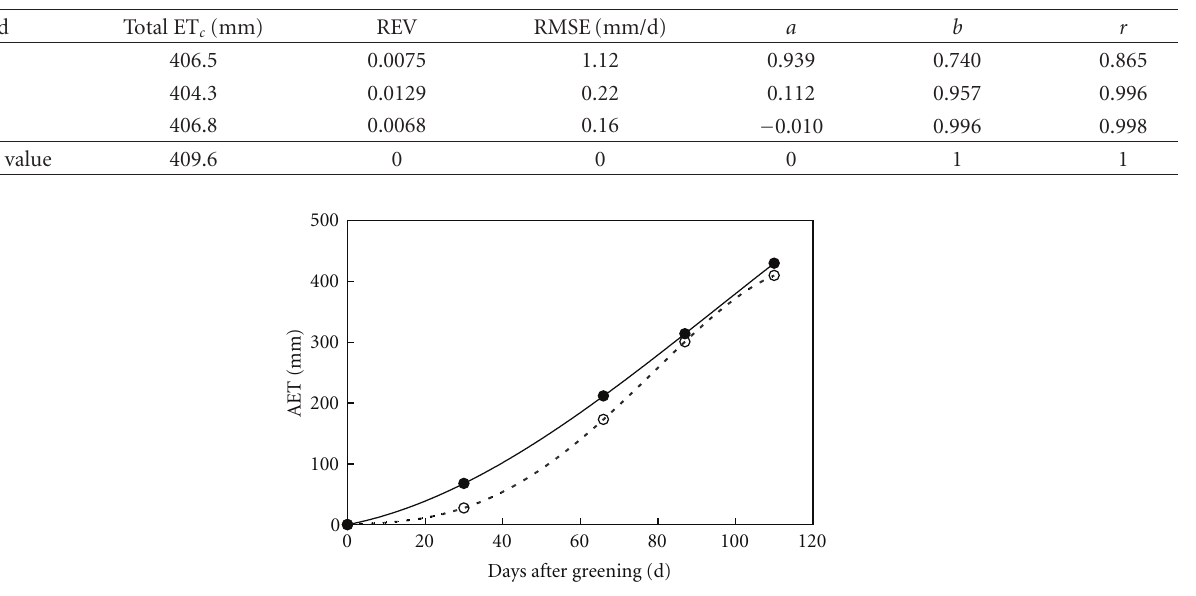
Figure 2: Accumulated values of reference (dot) and crop (circle) evapotranspiration and corresponding interpolation polynomials (solid and dashed lines) from greening to harvesting of winter wheat in 2003.